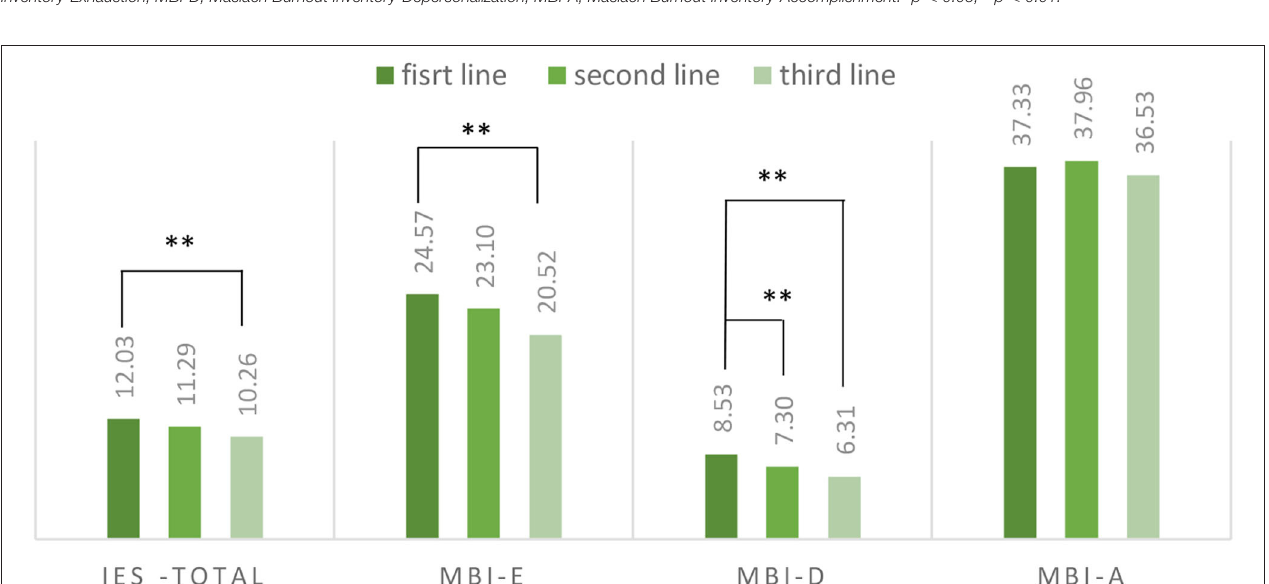
0.457; p < 0.001). The other significant predictive factors are behavioral disengagement ( β = 0.247; p < 0.001); blame ( β = 0.156; p < 0.001); substance use ( β = 0.91; p = 0.001); positive reinterpretation ( β = − 148; p < 0.001), emotional support ( β